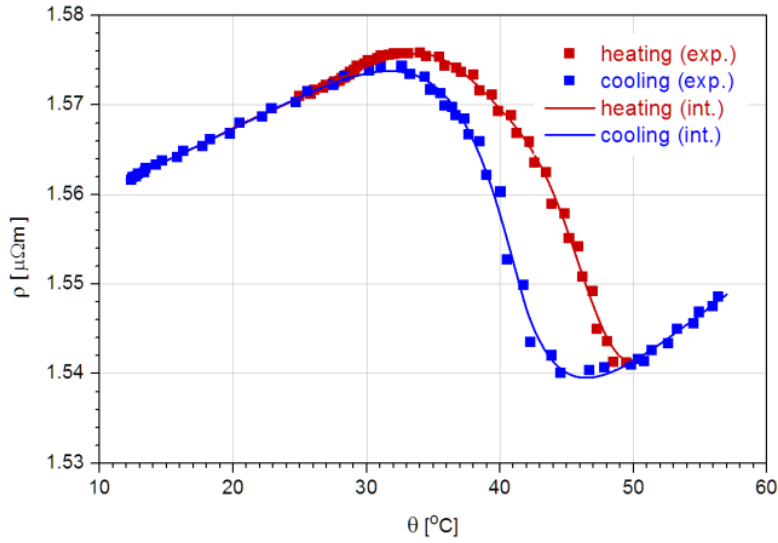
Figure 8. Evolution of the electrical resistivity of the Ti-Ni-Cu film along a heating/cooling cycle,